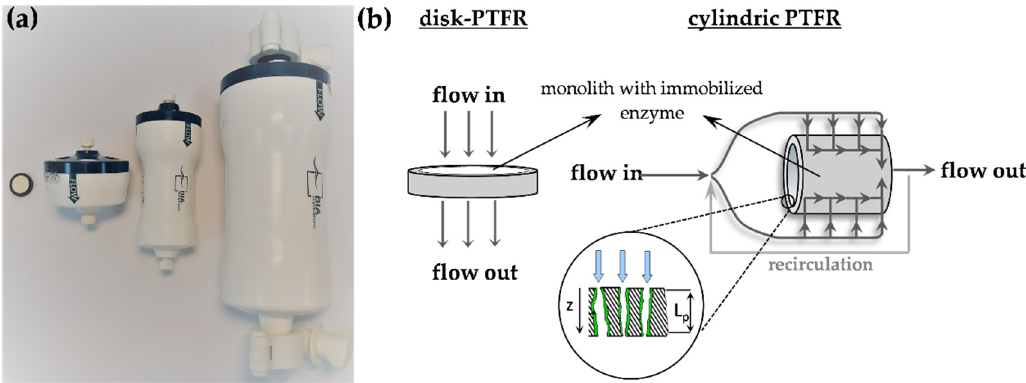
Figure 8. Design of monolithic PTFR: ( a ) disk-PTFR (V = 0.34 mL) and cylindric PTFRs with a total volume of 1, 8 and 80 mL (from left to right); ( b ) schematic representation of the design and the flow regime in the PTFRs (Lp = pore length, z = running coordinate).